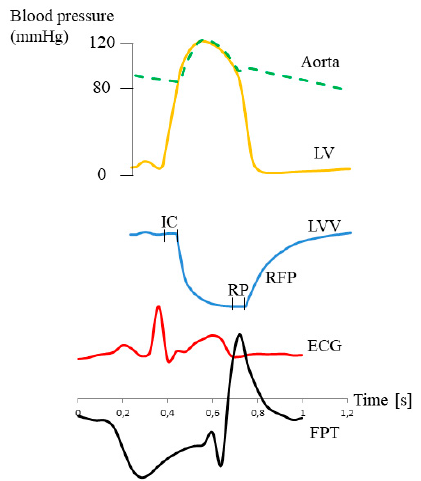
Figure 5. Presumptive relation between pleural pressure pulse (PPP) and the changes in heart ventricle volume. Figure modeled on a figure from G. Ross’s book Essentials of Human Physiology , Second Edition 1984, Year Book Medical Publishers Inc., London. Yellow line, pressure in left ventricle (LVP); blue line, left ventricle volume (LVV); IC, isovolumetric contraction; RP, relaxation period; RFP, rapid filling phase; red line, ECG tracing; black line, finger pulse trace (FPT). Table 1. Comparative characteristics of baseline parameters and data on thoracentesis in patients with well visible, poorly visible, and undetectable pulsations. Data are presented as numbers and percentages or medians and IQRs. Parameter Waves + Waves − Number of Patients